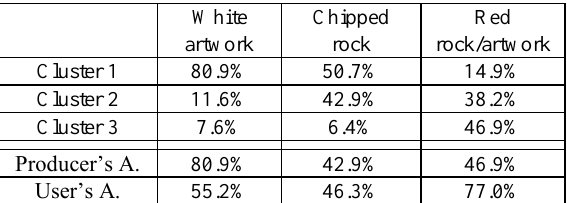
Table 2: Confusion matrix test 1.